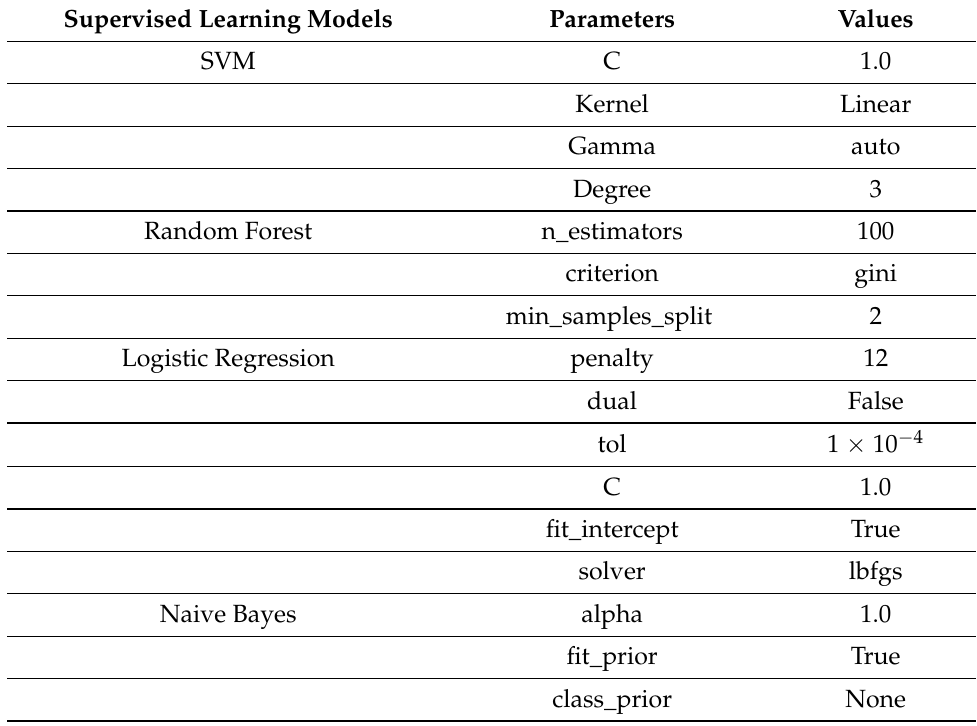
Figure 4. Framework of model with code metrics as input. Table 4. Parameter hypertuning for Supervised ML